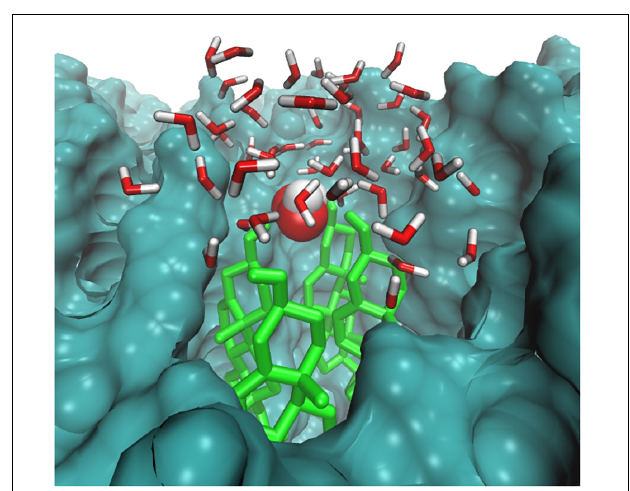
FIGURE 6 | Simulation snapshot showing H 2 O 2 species in the headgroups regions at 20.6593 ns. The H 2 O 2 species is presented according to element color. The cholesterol is shown in light green color. The rest of the bilayer is shown as surface representation with dark green color. The water molecules within 8 Å are shown with the default